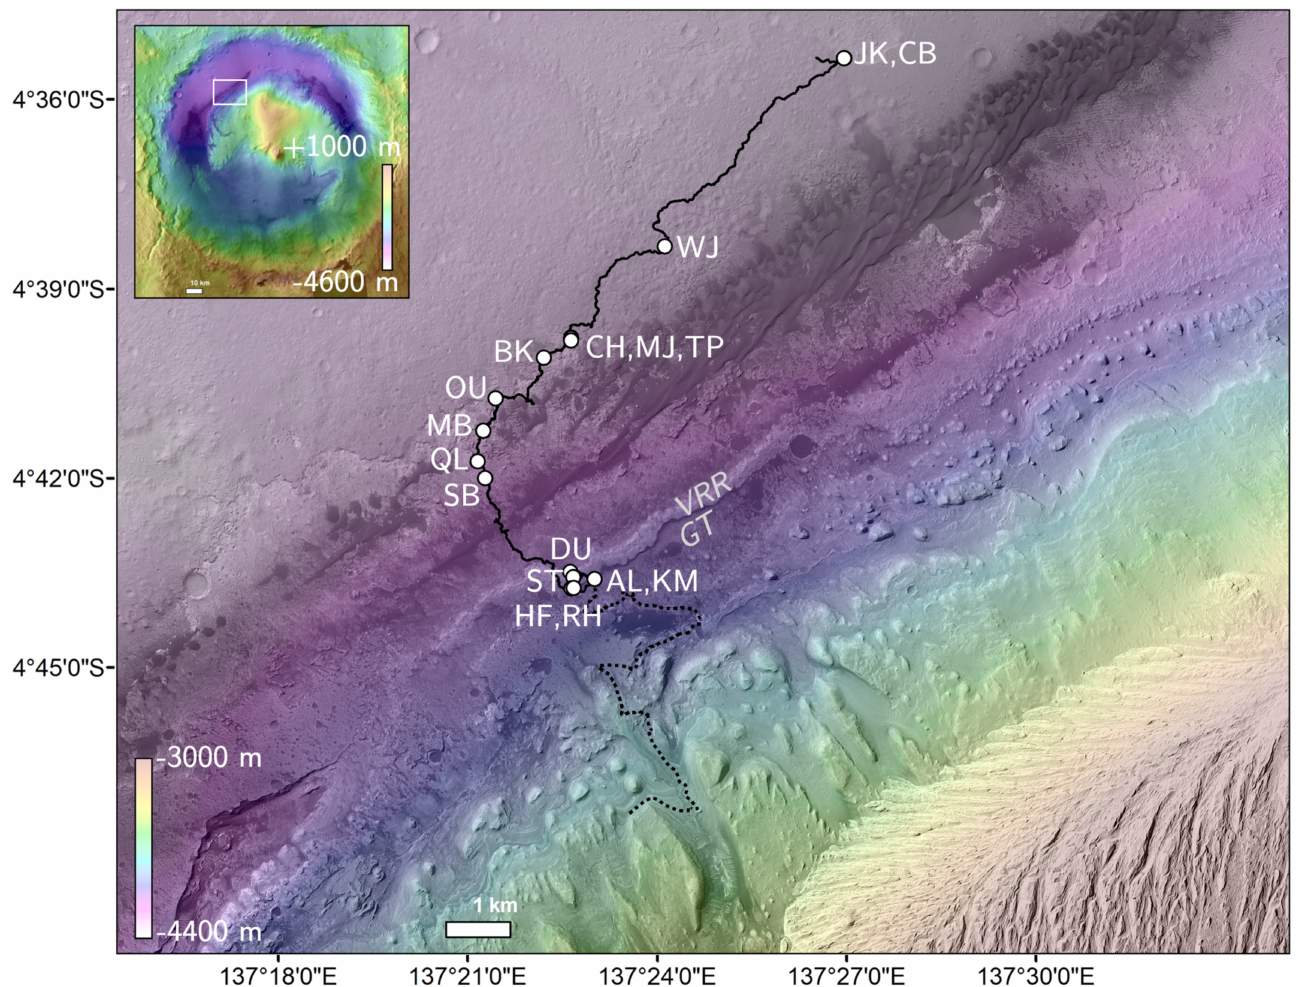
Figure 1. Elevation of northwestern Mount Sharp from the Mars Orbiter Laser Altimeter instrument, overlain on a Context Camera (CTX) image of the area. Inset shows elevation of all Gale crater, with the rover traverse region highlighted by the white square. The rover traverse route through sol 2390 (solid line) and subsequent planned route (dashed line) are shown. Labeled in gray italics are Vera Rubin Ridge (VRR) and Glen Torridon clay mineral-rich region (GT). White circles show locations of the fluvio-lacustrine drill holes through sol 2390. Abbreviations: JK: John Klein, CB: Cumberland, WJ: Windjana, CH: Confidence Hills, MJ: Mojave, TP: Telegraph Peak, BK: Buckskin, OU: Oudam, MB: Marimba, QL: Quela, SB: